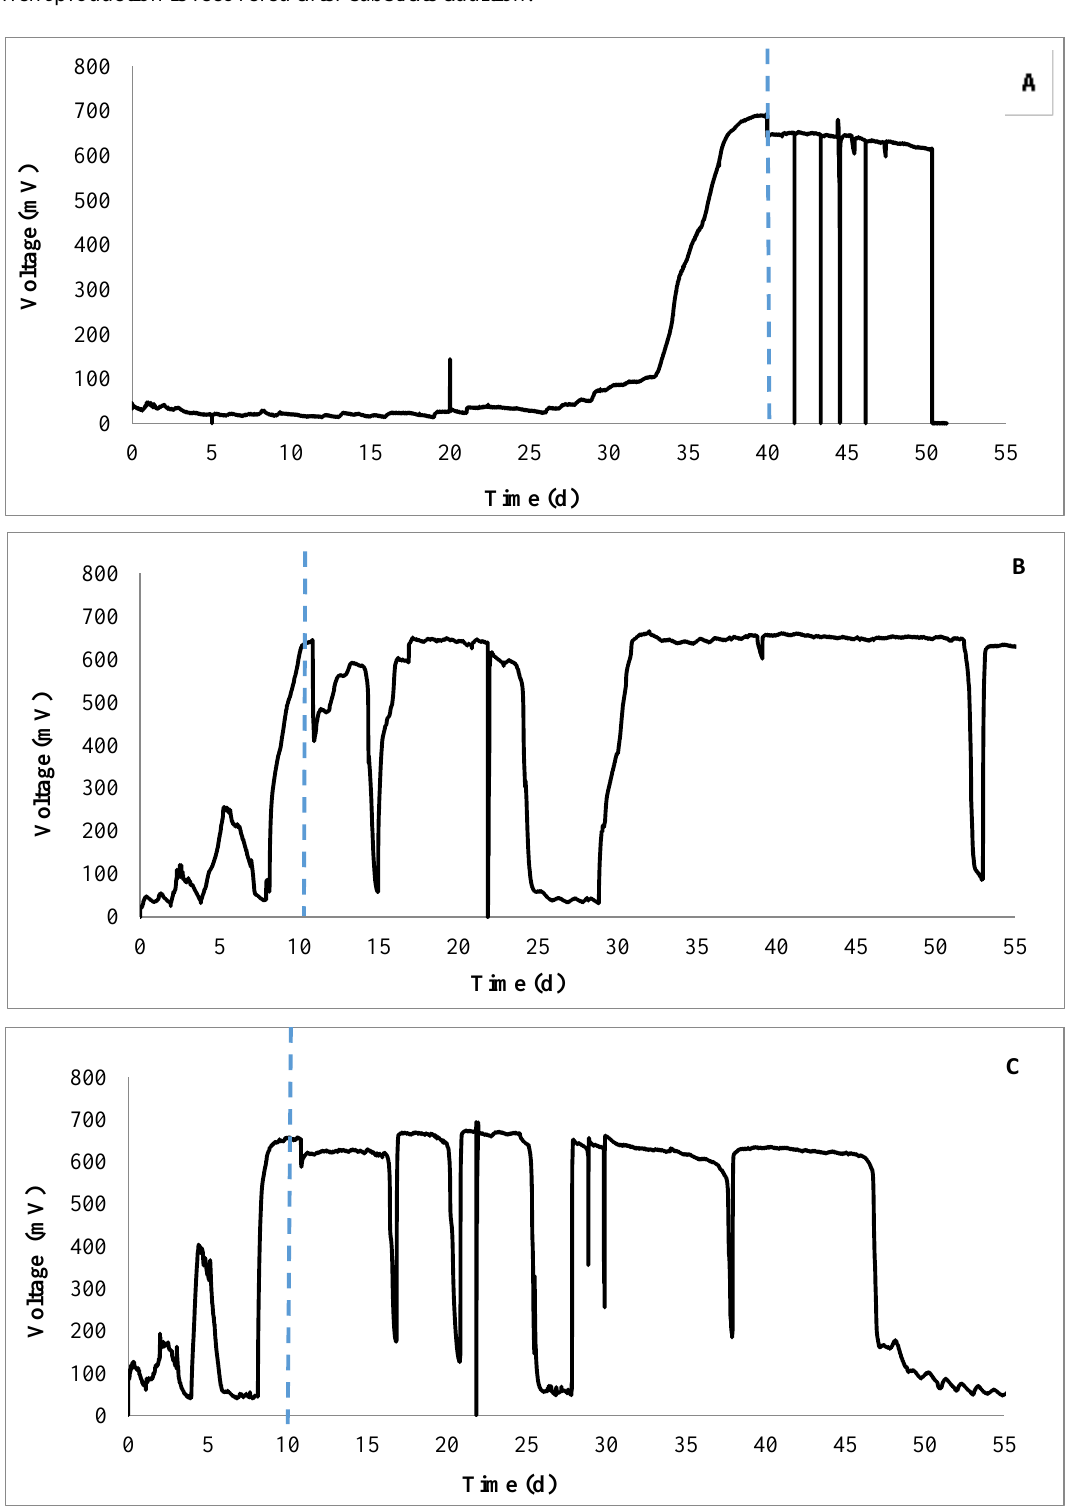
Figure 3. A. Voltage (mV) versus time in an unmodified anode of the MFC; B. Voltage (mV) versus time in a modified anode with multiwall nanotube (MWCNT); C. Voltage (mV) versus time in a modified anode with multiwall nanotube and Meldola’s Blue- Dimethylformamide